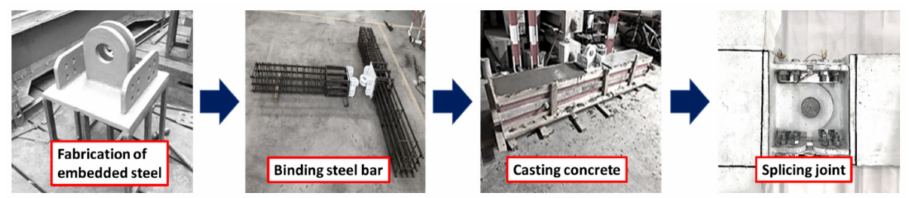
Figure 5. Flow chart of fabrication and assembly of test